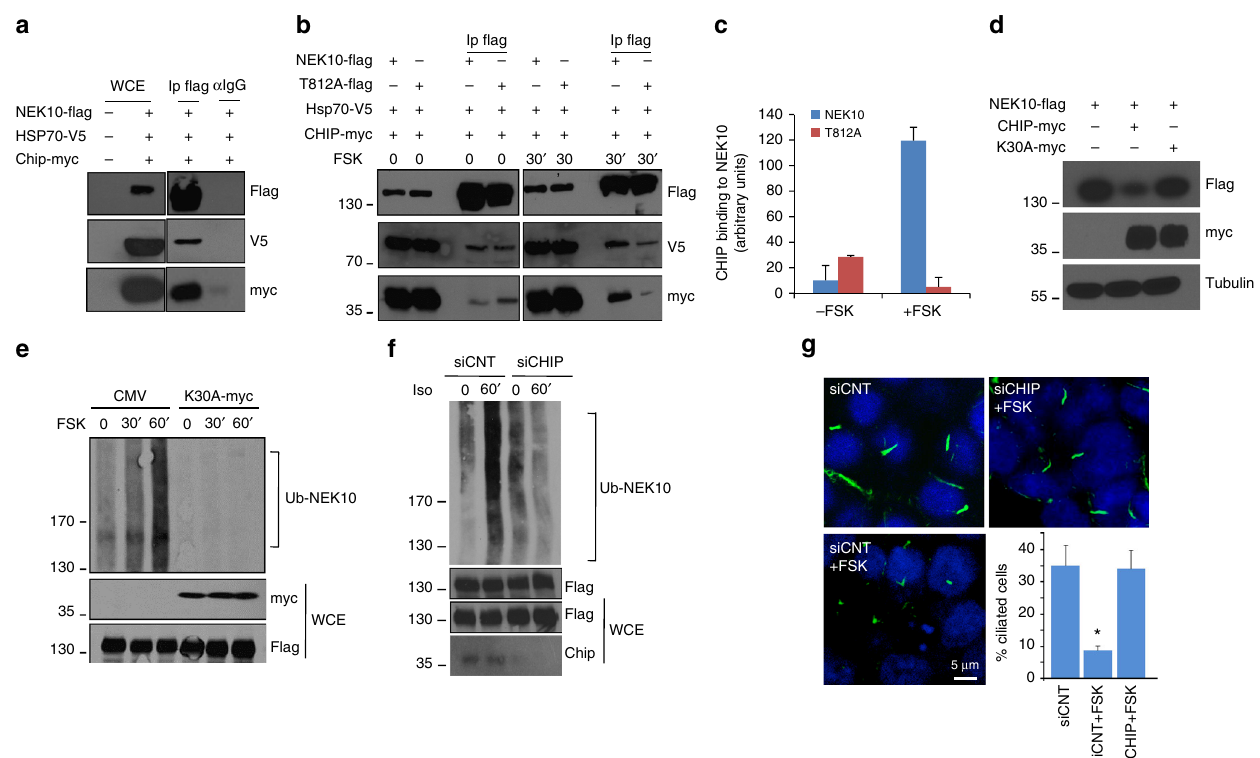
Fig. 6 CHIP ubiquitylates and degrades NEK10. a Cells were co-transfected with NEK10- fl ag, HSP70-V5 and CHIP-myc. To prevent NEK10 degradation, cells were treated with MG132 (20 µ M) for 8 h before collecting. Lysates were immunoprecipitated with anti- fl ag or with control IgG. The precipitates and lysates were immunoblotted with the indicated antibodies. b Cells were co-transfected with NEK10- fl ag vectors (either wild type or T812A mutant), HSP70-V5 and CHIP-myc, serum deprived for 24 h and left untreated or stimulated with FSK. Lysates were immunoprecipitated with anti- fl ag. The precipitates and lysates were immunoblotted with the indicated antibodies. c Cumulative data of the experiment shown in b . The results represent the mean values ± S.E. of three independent experiments. d Lysates from cells co-transfected with NEK10- fl ag and CHIP (either wild type or K30A mutant) were immunoblotted with the indicated antibodies. e Cells were co-transfected with HA-ubiquitin, NEK10- fl ag and CHIP K30A -myc or with control plasmid (CMV). 24 h after transfection, to avoid degradation of the ubiquitinated target protein, the cells were treated with MG132 (20 µ M) for 8 h and then stimulated with FSK. Lysates were subjected to immunoprecipitation with anti- fl ag and immunoblotted with anti-HA, anti- fl ag and anti-myc antibodies. f Cells co-transfected with HA-ubiquitin, NEK10- fl ag and siRNAs (either control siRNA or siCHIP) were serum-deprived overnight and stimulated with isoproterenol. Lysates were subjected to immuno-precipitations with anti- fl ag antibody. Ubiquitinated NEK10 was revealed by immunoblot with anti-HA antibodies. g Cells were transiently transfected with control or with siRNAs targeting CHIP, serum-deprived for 36 h and then left untreated or stimulated with FSK. Primary cilia were visualized by immunostaining for acetylated tubulin. Cumulative data from fi ve independent experiments are shown. For each group a minimum of 100 cells/experiment was averaged. * p < 0.05 versus siCNT and siCHIP +